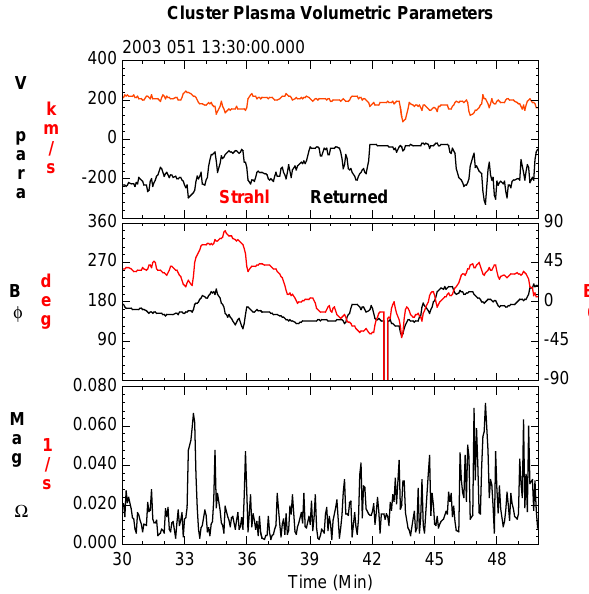
Fig. 10. High resolution plot of the parallel strahl and return ve- locities, the φ and θ GSE components of the C1 magnetic field and the magnitude of the vorticity for the time period when the return electrons are waving across the